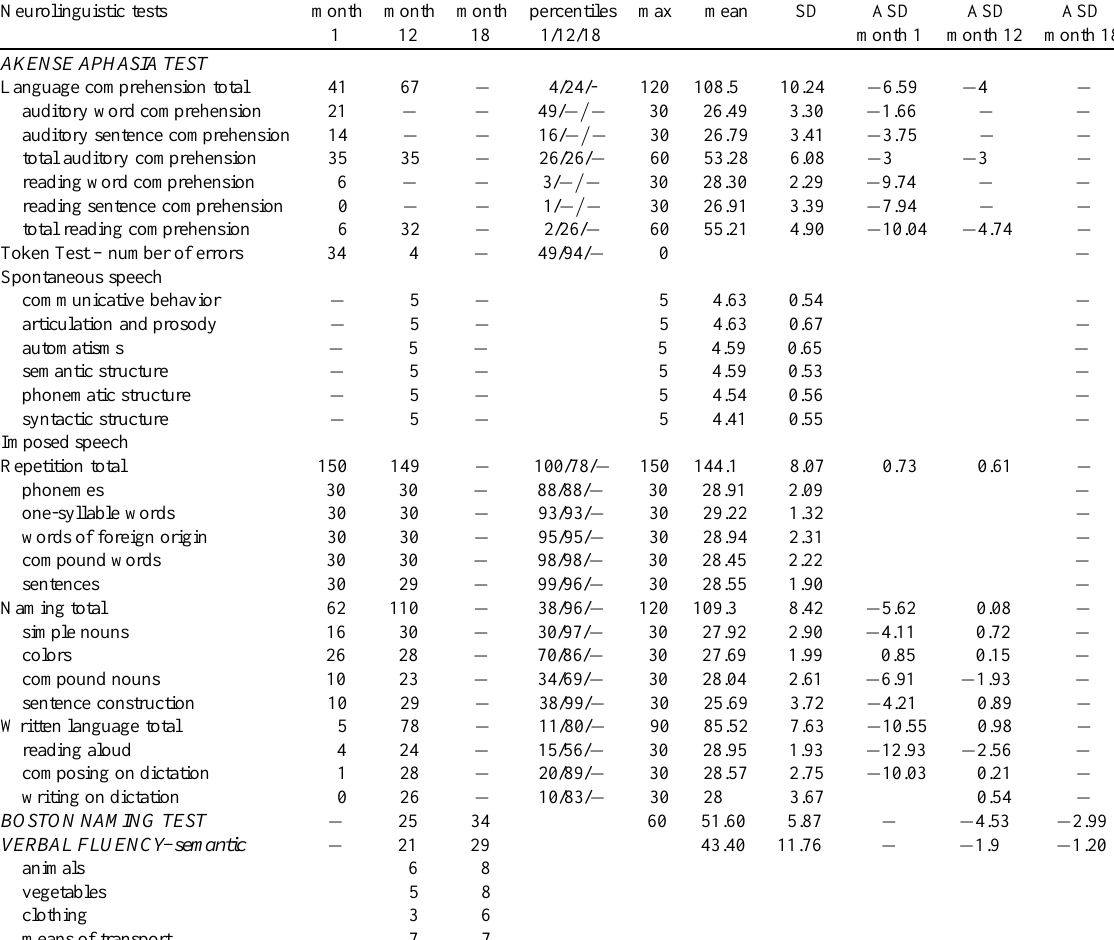
Table 1 Neurolinguistic test results in the lesion and late phase of the